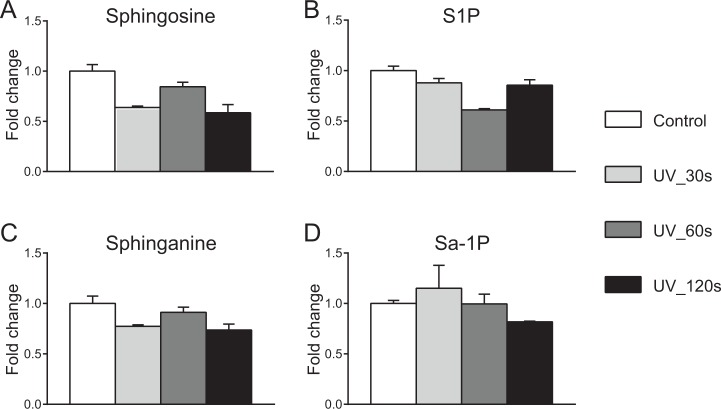
The effects of UV irradiation on sphingolipid levels.Cells in 60 mm culture dishes were irradiated under 350–450 nm UV light on ice for indicated time period. Cells were collected immediately after UV irradiation. Extracted lipids were derivatized by AQC, and measured by LC-MS/MS. Values were normalized with respect to the amount of C17 internal standards and cell numbers. Data represents the average of three independent experiments. Error bars represent SEM.